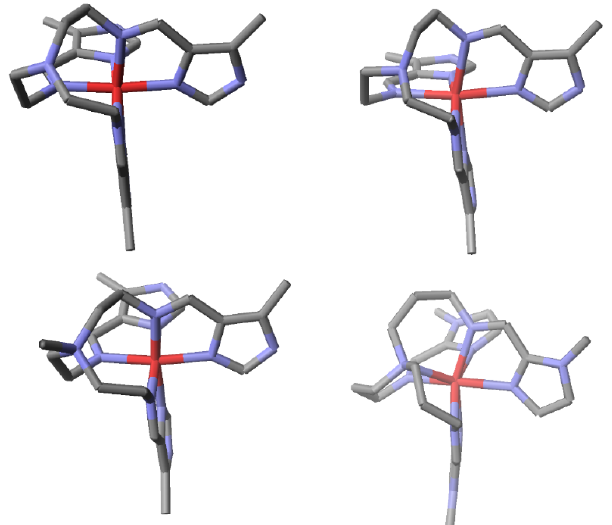
Figure 2. Structural diagrams of four iron(II) complexes illustrating the four backbone geometries described above. Hydrogen atoms and anions have been omitted for clarity. Nitrogen atoms are in blue